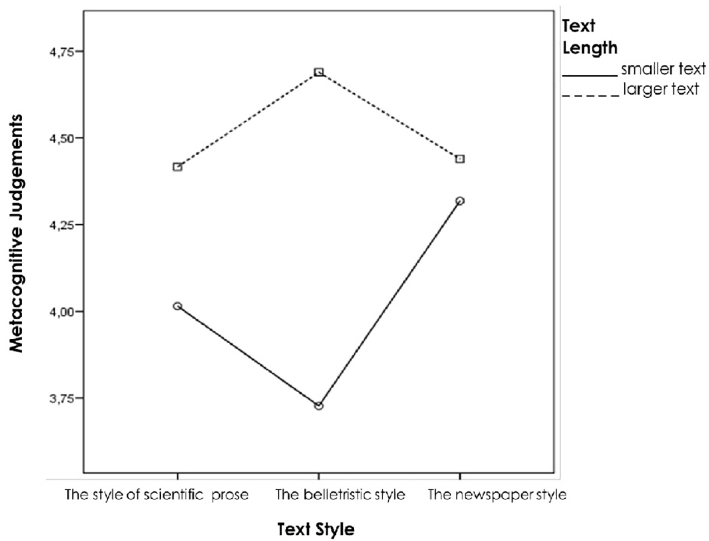
Figure 3. Performance rankings of metacognitive judgements in terms of text style and length.